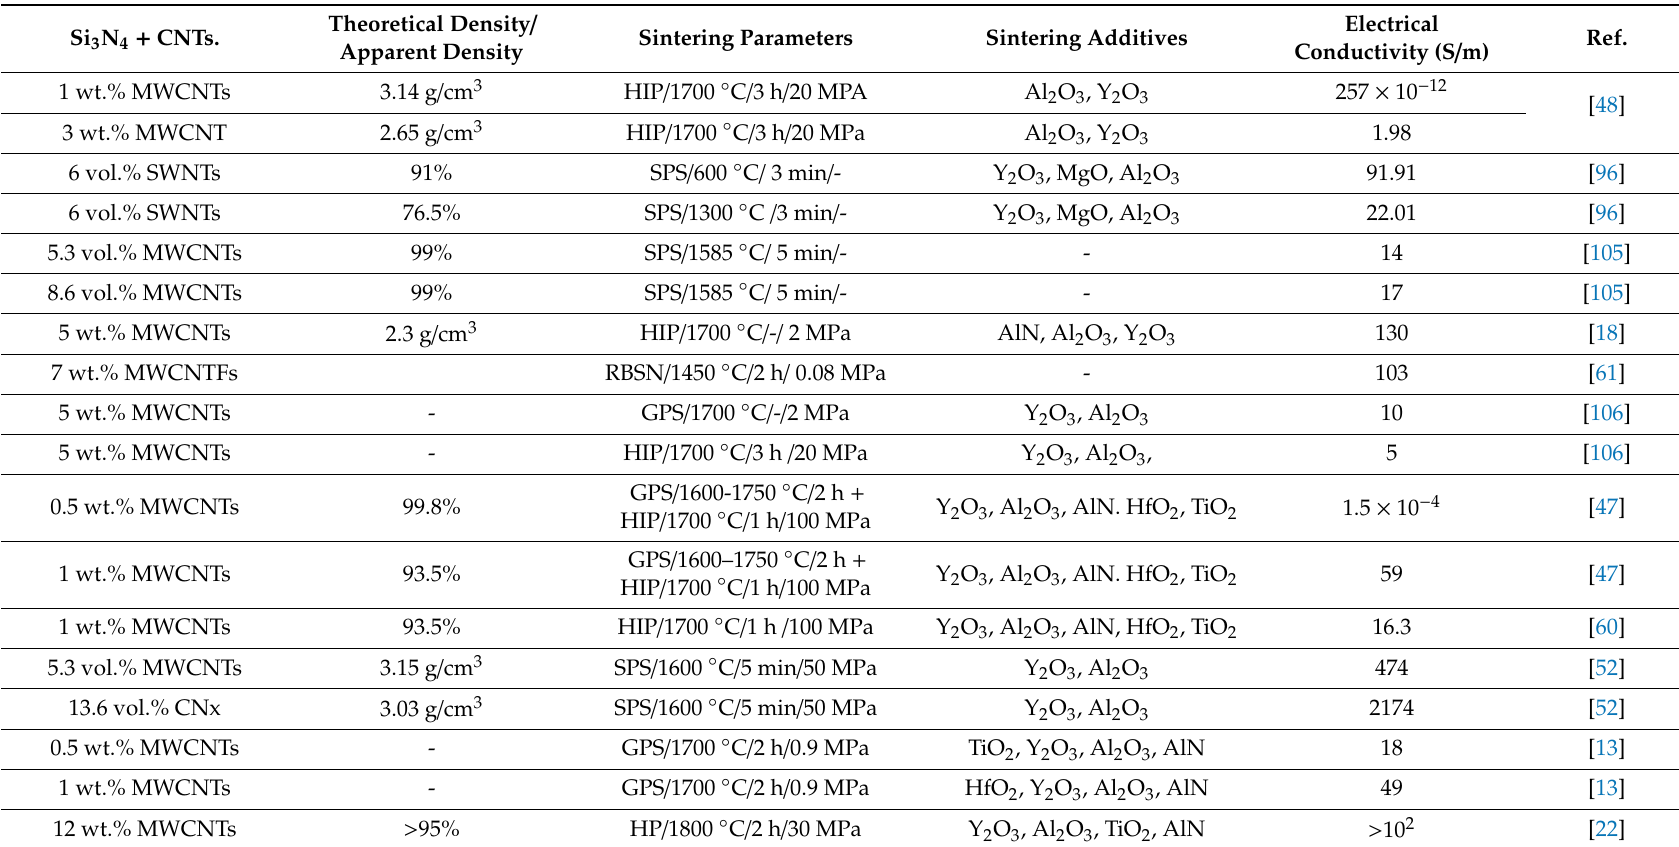
Table 5. Electrical conductivity of CNT-reinforced Si 3 N 4